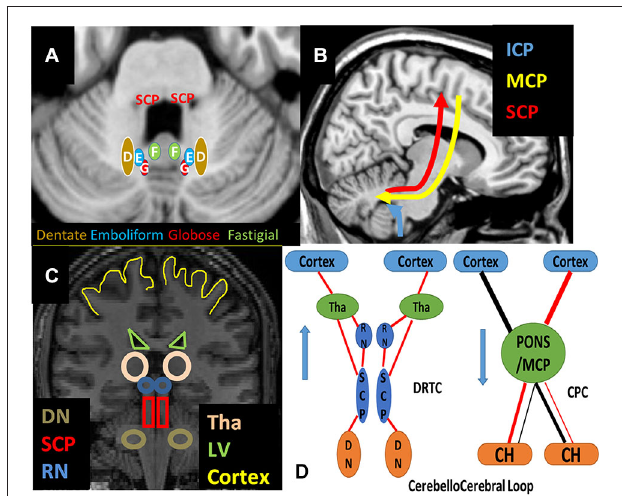
FIGURE 1 | Schematic Representation of (A) deep cerebellar nuclei on axial T1w, (B) cerebellar peduncles on sagittal, (C) relevant structures on coronal T1w and (D) cerebellocerebral loop pathways are shown . Abbreviations : CH: Cerebellar Hemisphere, CPC: Cortico-Ponto-Cerebellar Pathways, DN: Dentate Nucleus, DRTC: Dentate-Rubro-Thalamo-Cortical Pathways, ICP: Inferior Cerebellar Peduncle, LV: Lateral Ventricles, MCP: Middle Cerebellar Peduncle, RN: Red Nucleus, SCP: Superior Cerebellar Peducles Tha: